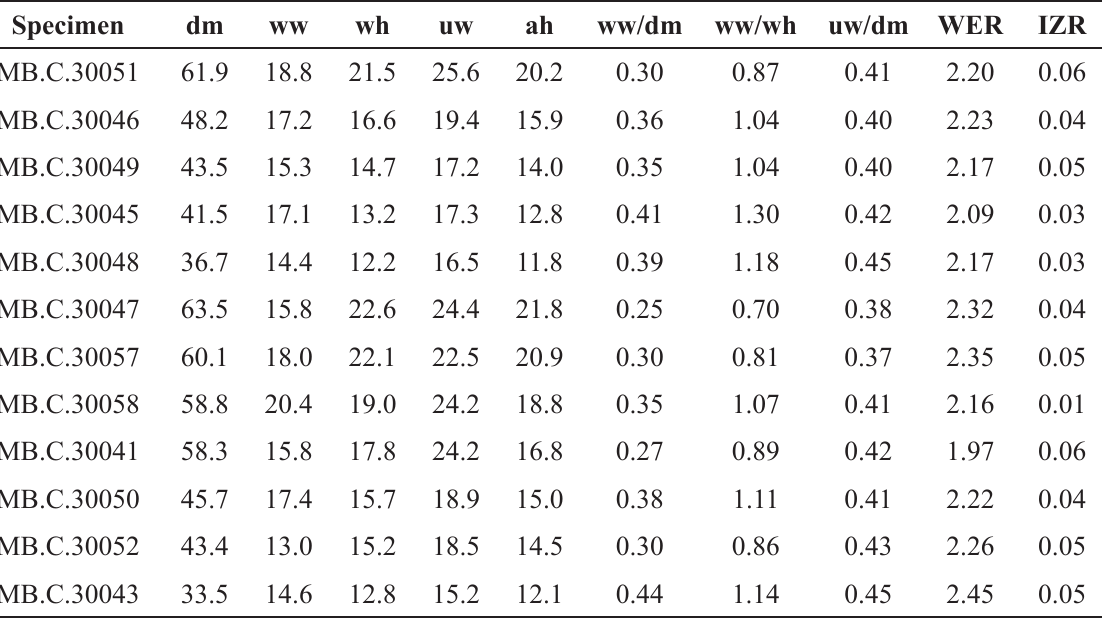
Table 31. Conch dimensions (partly estimated) and ratios of selected specimens of Abichites alibashiensis Korn & Ghaderi in Korn et al. (2016) from Baghuk